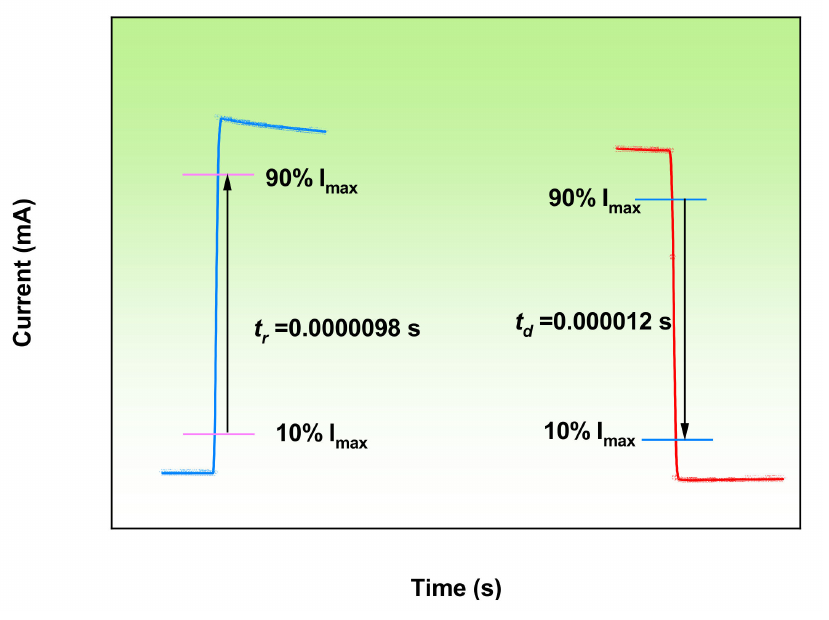
Figure 8. Response time of the detector. Table 2. The electrical properties of the